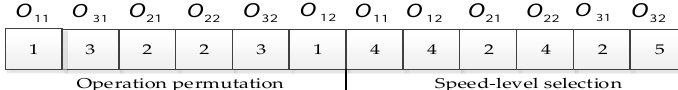
Figure 2. Scheduling solution representation.